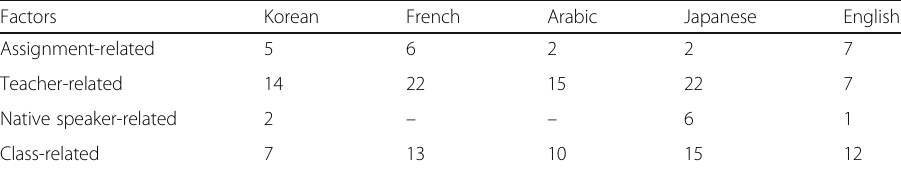
Table 9 Situations causing